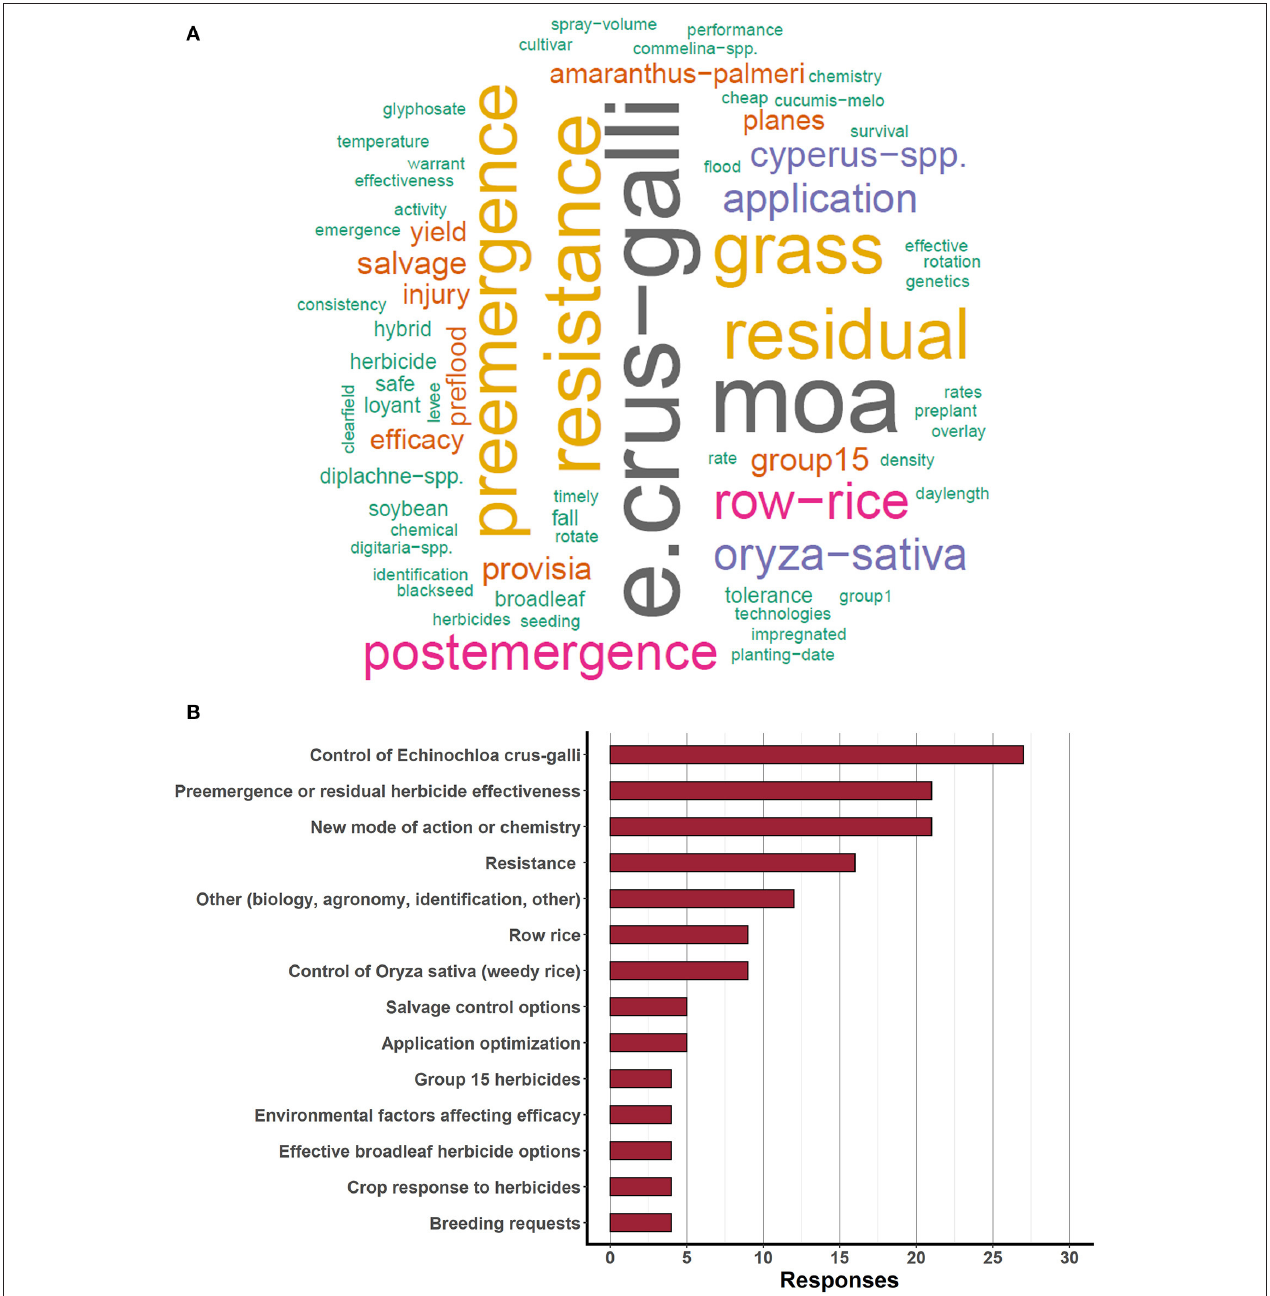
FIGURE 2 | Results for perceived areas of weed management research needs that would benefit rice producers’ operation’s profitability and/or overall weed control as reported by survey respondents. (A) WordCloud analysis of singular keywords or phrases generated from responses for rice weed management research needs. Words with a similar size and color received a similar number of responses. The larger the word, the more responses that keyword received [i.e., Echinochloa-crus-galli and MOA (mode-of-action) were the top two responses]. Some respondents provided more than one keyword resulting in a total number of observations greater than individual respondents ( n = 124). (B) Groupings of perceived areas into broader categories of research to provide a more generalized view for future research directions ( n = 76).